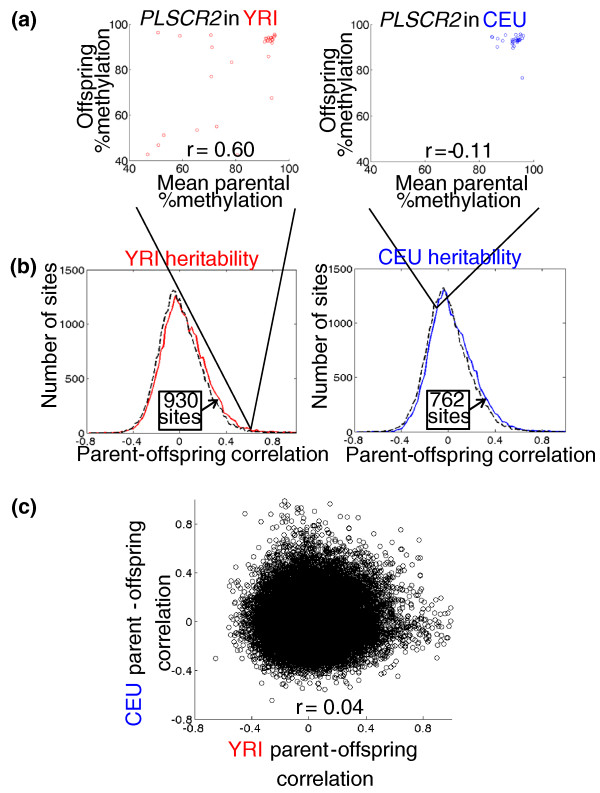
Population specificity of DNA methylation heritability. (a) An example of a CpG site (near PLSCR2: chromosome 3, base 147696535) whose methylation is heritable in YRI, but not CEU, as assessed by the similarity of average parental methylation to their offspring methylation (each point represents one family trio). (b) Histograms comparing the observed distribution of per-site heritabilities to a typical randomized distribution (numbers in the text are based on 1, 000 randomizations; Materials and methods). The greater number of sites at high heritabilities in the real data compared to random (arrows) is an estimate of the number of heritable sites we can detect in each population. (c) No similarity between heritabilities in each population (Pearson's r2 = 0.002; each point is a CpG site).